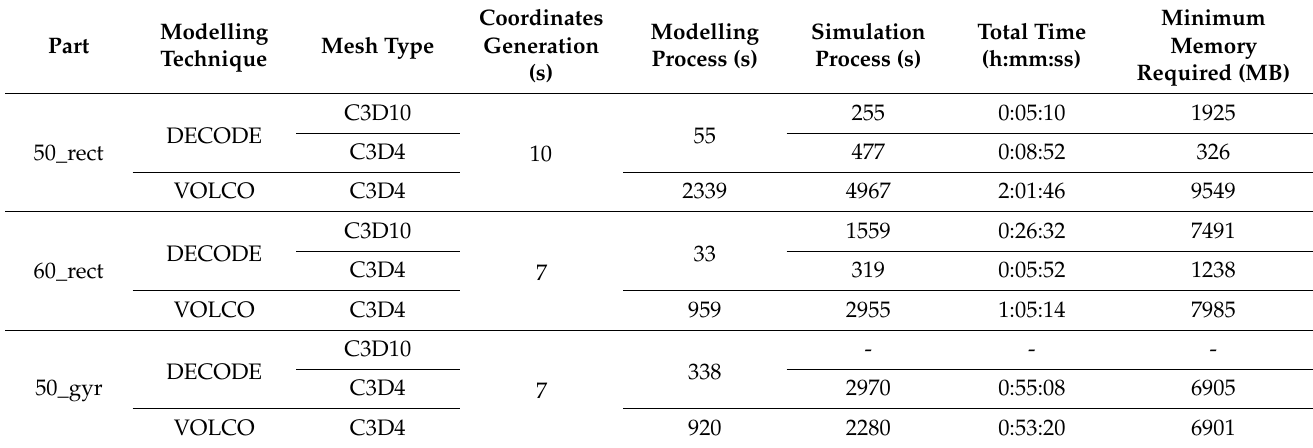
Table 6. CPU Time and Memory Required to Model and Simulate the